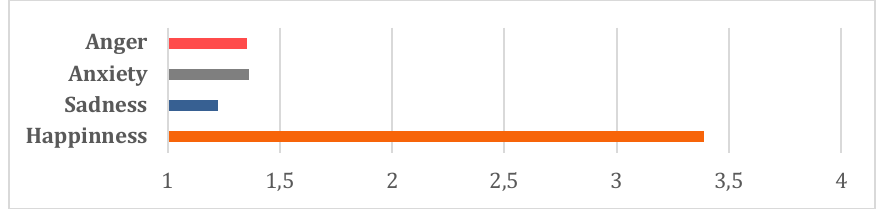
Fig. 7. Emotions when playing the game in new secondary school pupils.